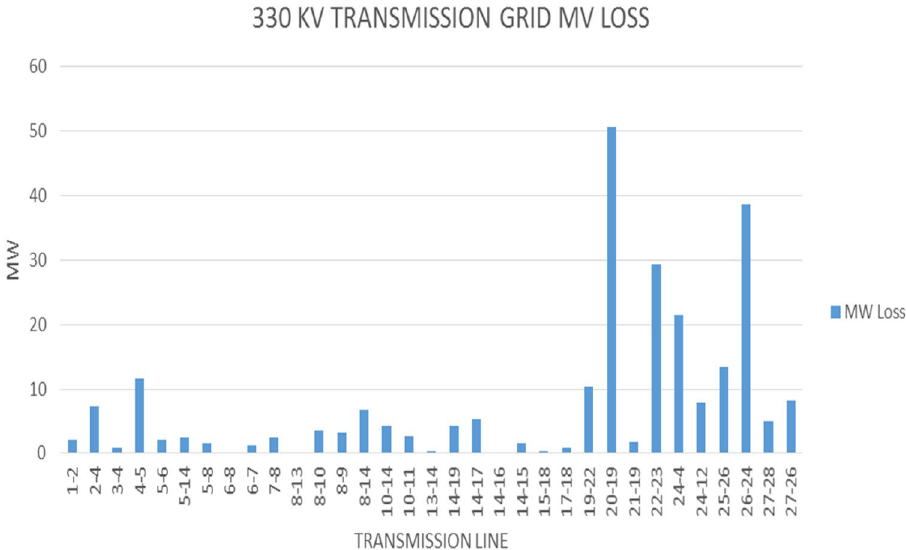
Fig. 8 Real power loss on the existing 330-kV grid